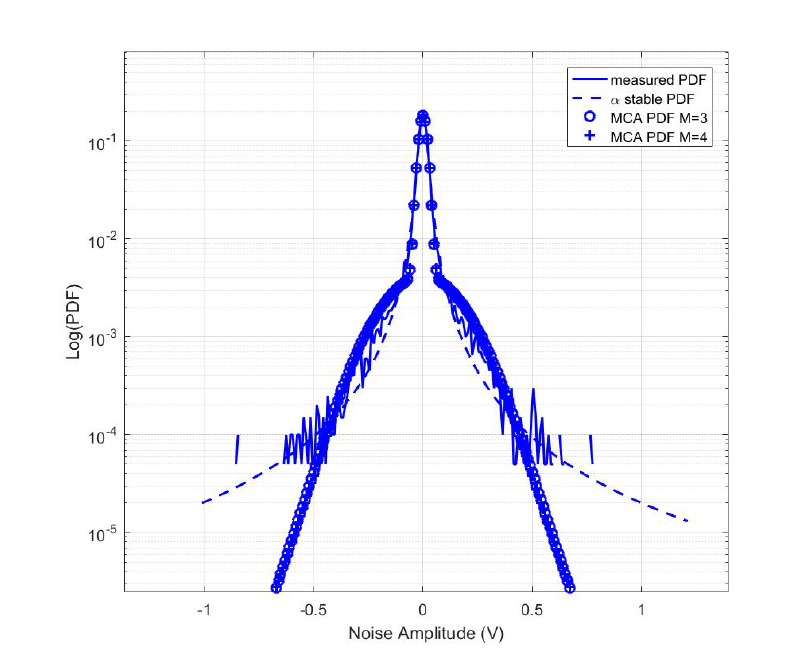
Figure 11. log(PDF) comparison of MCA , α stable model and measured noise data in China.